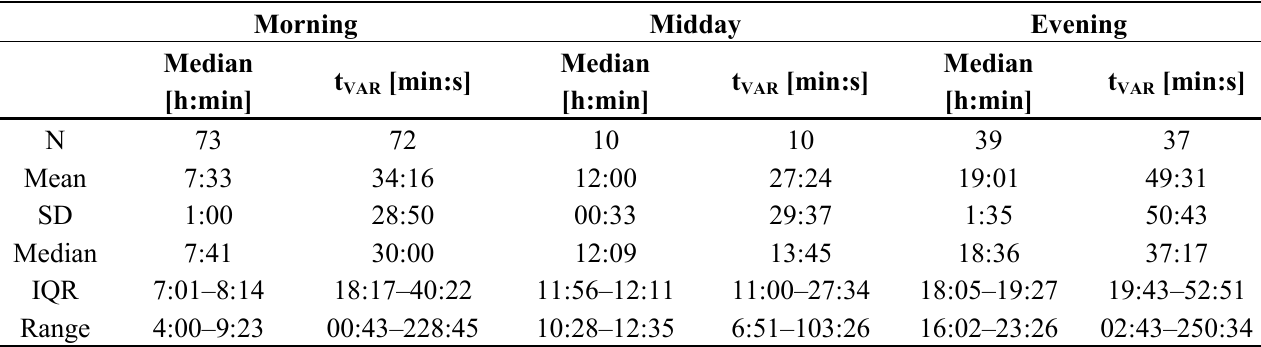
Table 2. Description of median intake time and time variability (t times for 78 patients. Parameters were calculated when at least three (median) or four (t ) records per intake time were available. VAR